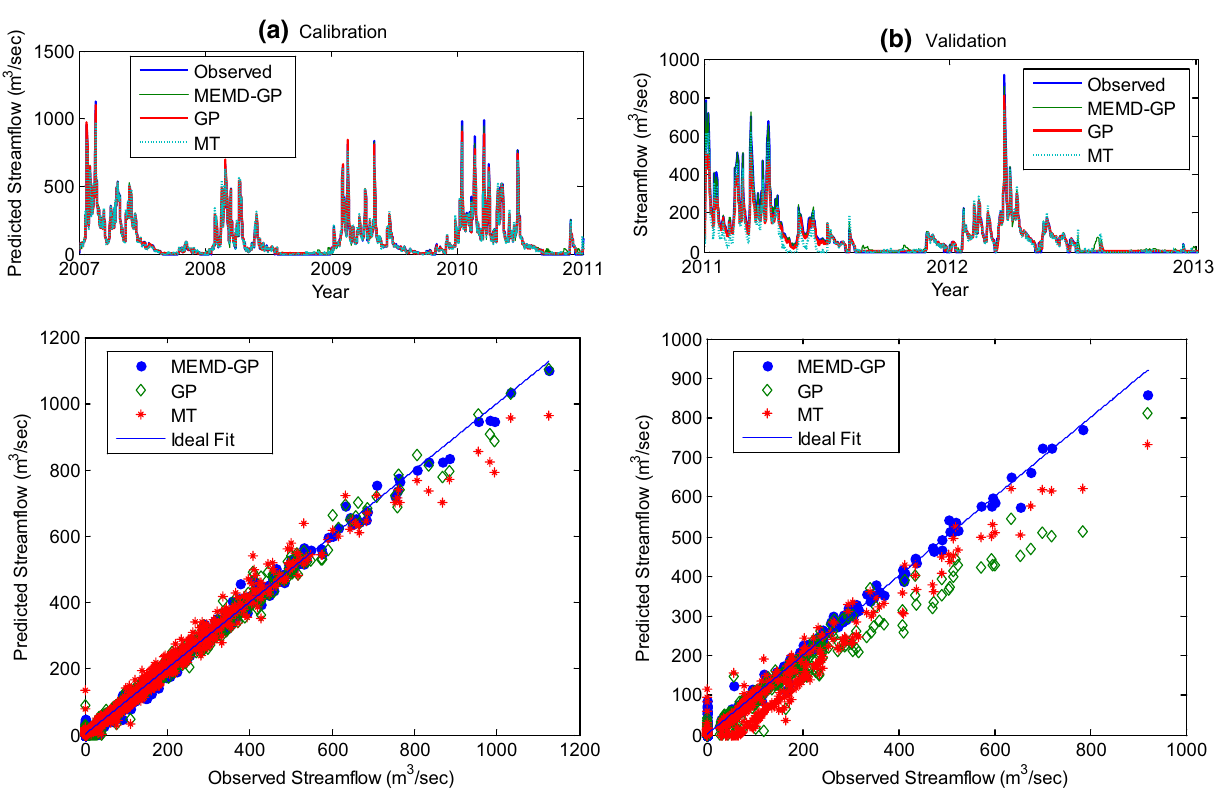
Fig. 6 Daily discharge predictions for Malakkara station by different methods. Upper panels show time series plots; lower panels show scatter